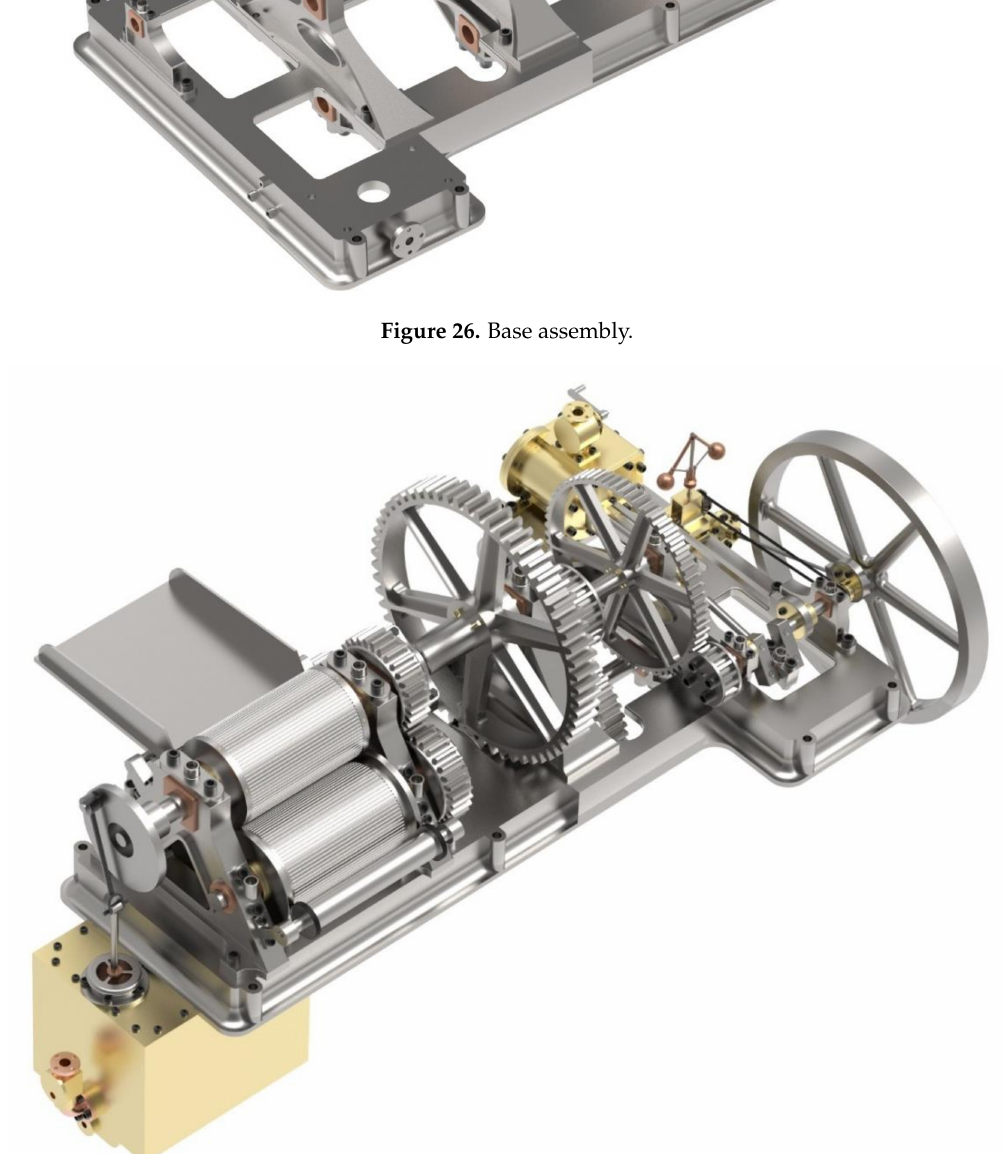
Figure 27. Final assembly of the 3D CAD